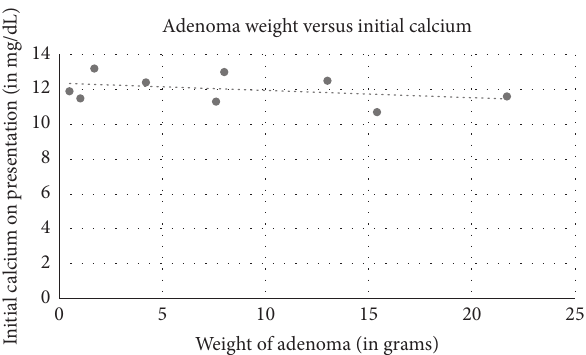
Figure8:Weightofadenomaonpathologicalevaluationcorrelation to initial calcium on presentation. Correlation coefficient −